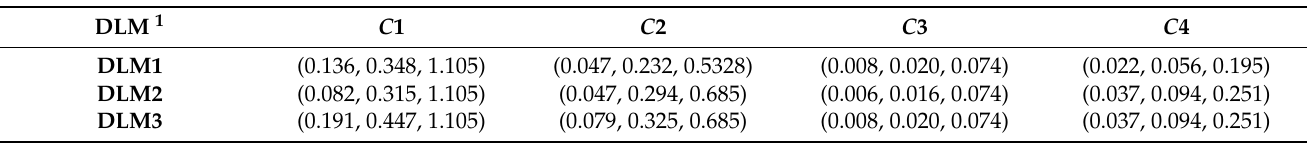
Table 9. Weighted normalized fuzzy decision matrix for three distance learning course assessment according to the military students’ opinion of the quality of these courses.